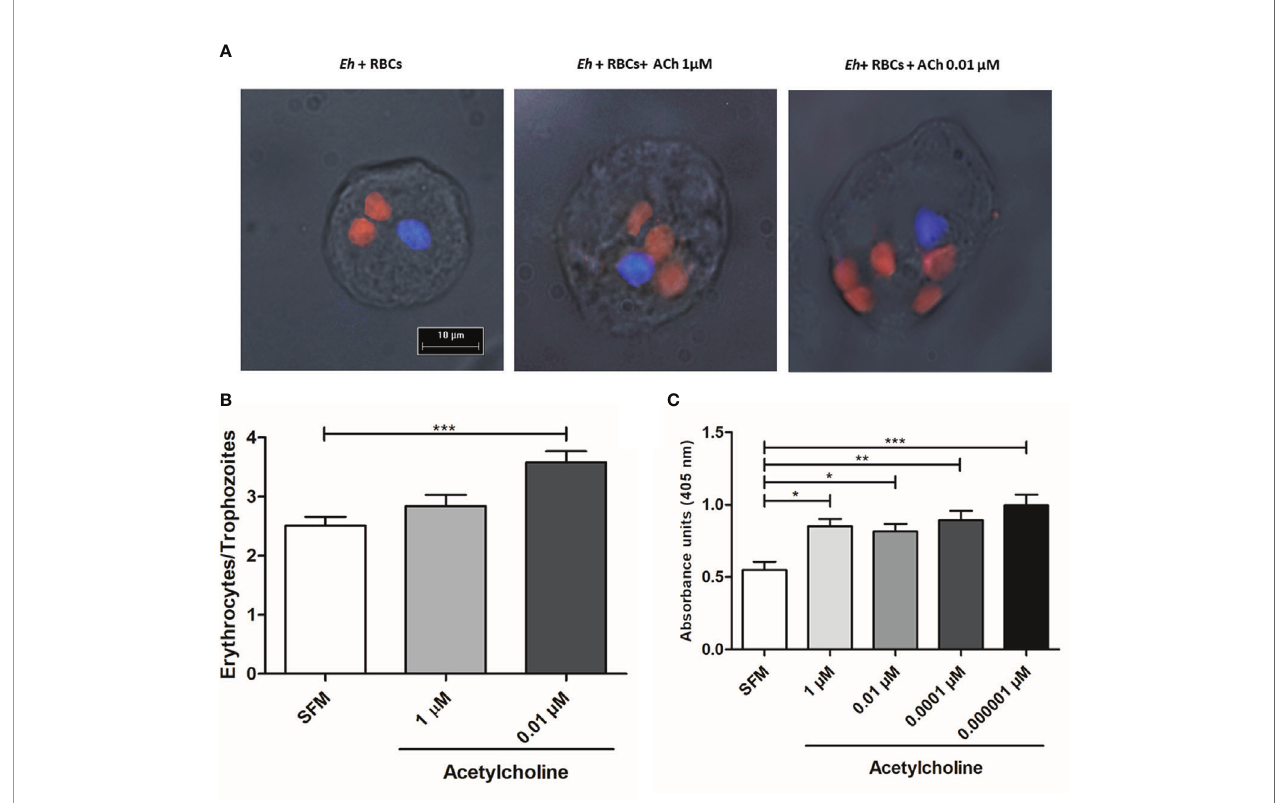
FIGURE 8 | Acetylcholine increases phagocytic capacity of E. histolytica . (A) Ingested erythrocytes by trophozoites treated with ACh, evidenced by fl uorescence microscopy (X40 representative images). (B) Mean number of phagocytosed erythrocytes by trophozoites in SFM or treated for 30 min with and 1 µM and 0.01 µM ACh. (C) Hemoglobin quanti fi cation by spectrophotometric analysis at 405 nm, as indirect determination of erythrophagocytosis of trophozoites treated with different concentrations of ACh for 1 h. Data correspond to the mean ± SEM of three independent experiments (n = 3). The statistical analysis was performed with the Kruskal Wallis and Dunn posttest method, where the values of *p < 0.05, **p < 0.01 and ***p < 0.001 were considered signi fi